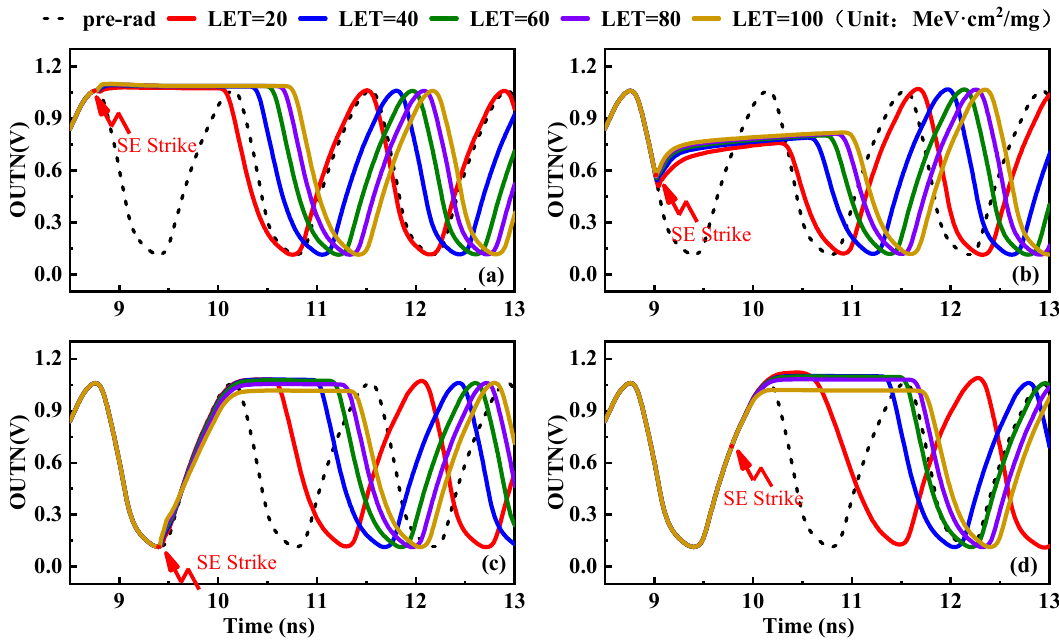
Figure 7. Simulation results of the response to the SET with different bombardment energies in the VCO. ( a ) Bombardment at the peak. ( b ) Bombardment when the wave falls. ( c ) Bombardment at the trough. ( d ) Bombardment when the wave rises.